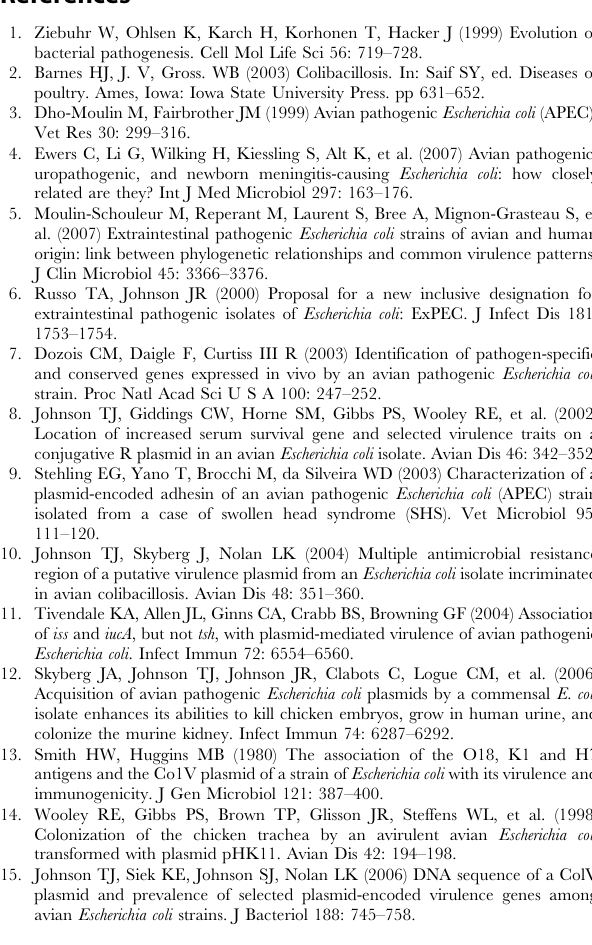
Figure S2 The genetic map of the region of pAPEC-1 containing the etsABC (A) and hlyF and ompT genes (B). This figure shows the genetic map of the region of pAPEC-1 containing the etsABC (A) and hlyF and ompT genes (B). Black arrows represent known ORF genes, white arrows represent hypothetical protein genes, and hatched arrows are Insertion sequences genes.